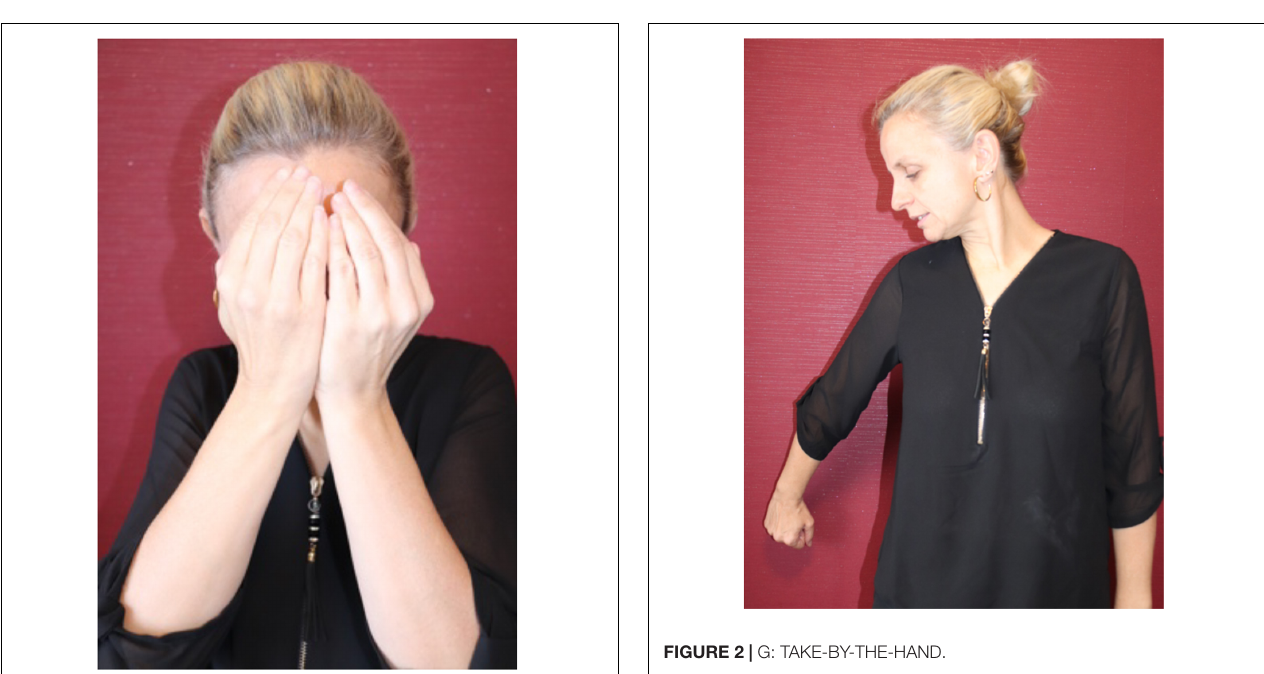
FIGURE 1 | G: COVER-EYES.